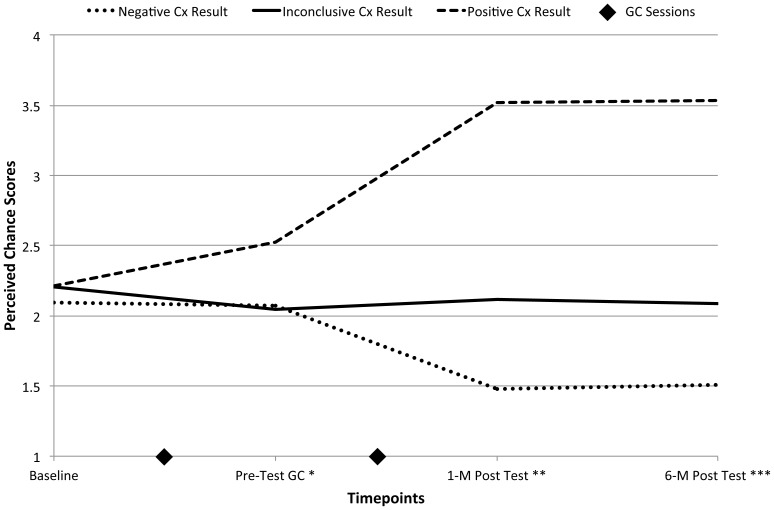

Perceived chance least squares estimates by Connexin result group before and after genetic testing.How likely is it that you have Connexin-26 related deafness? 1 = not at all likely, 2 = somewhat likely, 3 = highly likely, 4 = definitely. Main effects: Connexin p<0.0001, time p = 0.01; interaction Connexin x time p<0.0001; *Significant difference between Connexin-positive and Connexin-negative groups p = 0.02, and Connexin-positive and Connexin-inconclusive groups p = 0.02; **Significant difference between Connexin-positive and Connexin-negative groups p<0.0001, Connexin-positive and Connexin-inconclusive groups p<0.0001, and Connexin-negative and Connexin-inconclusive groups p = 0.0003; ***Significant difference between Connexin-positive and Connexin-negative groups p<0.0001, Connexin-positive and Connexin-inconclusive groups p<0.0001, and Connexin-negative and Connexin-inconclusive groups p = 0.0006. Cx = connexin; GC = genetic counseling; M = month.